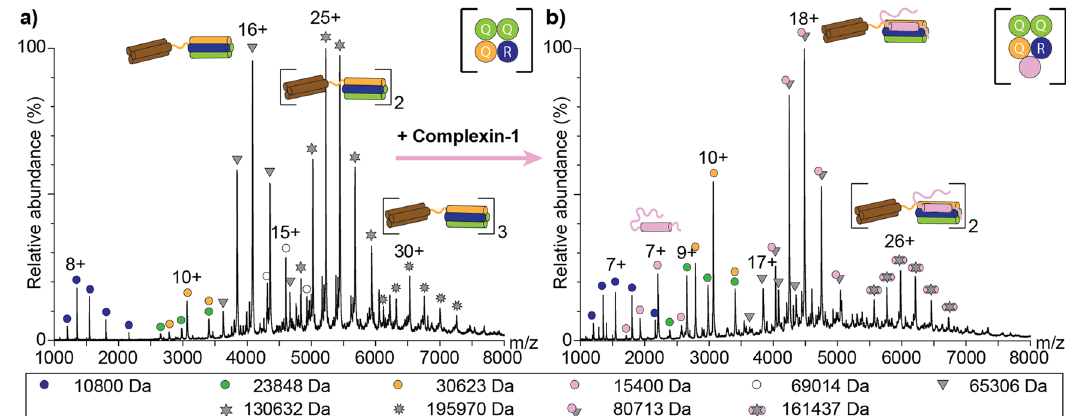
Fig. 5 Multimerisation of the fully assembled SNARE complex is prevented by Complexin-1. a Synaptobrevin-2, SNAP25 and Syntaxin-1A were mixed in a 1:1:1 ratio and analysed by native MS. Charge state series corresponding to the monomeric proteins (Synaptobrevin-2, blue; Syntaxin-1A, orange; SNAP25, green) as well as monomeric (grey triangles), dimeric (grey hexagonal stars) and trimeric (grey nonagonal stars) SNARE complexes were observed. b Upon addition of Complexin-1, SNARE complex oligomerisation is reduced. Charge states corresponding to the SNARE:Complexin-1 (grey triangle-pink circle) as well as a dimeric SNARE:Complexin-1 (grey hexagonal star-pink circle) complex were observed. The observed molecular weight is given for all proteins and complexes (see